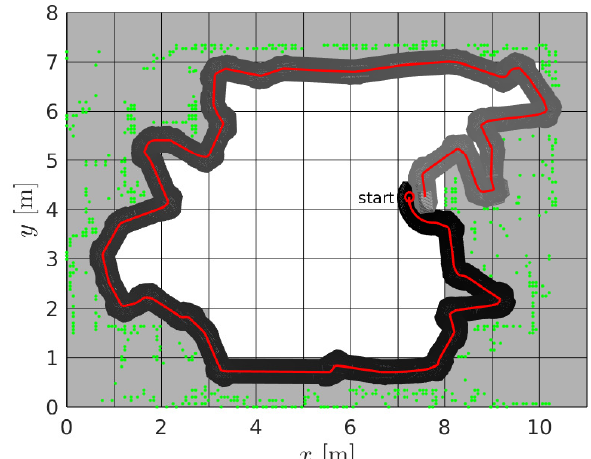
Figure 14. The wall following algorithm after SCCPP: driven trajectory (red line), and robot’s footprint in every point on the trajectory is presented degraded from black to